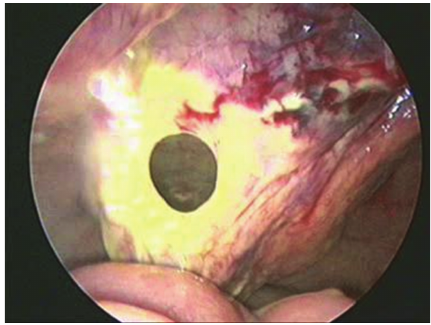
Figure 1: Laparoscopic imaging of bladder